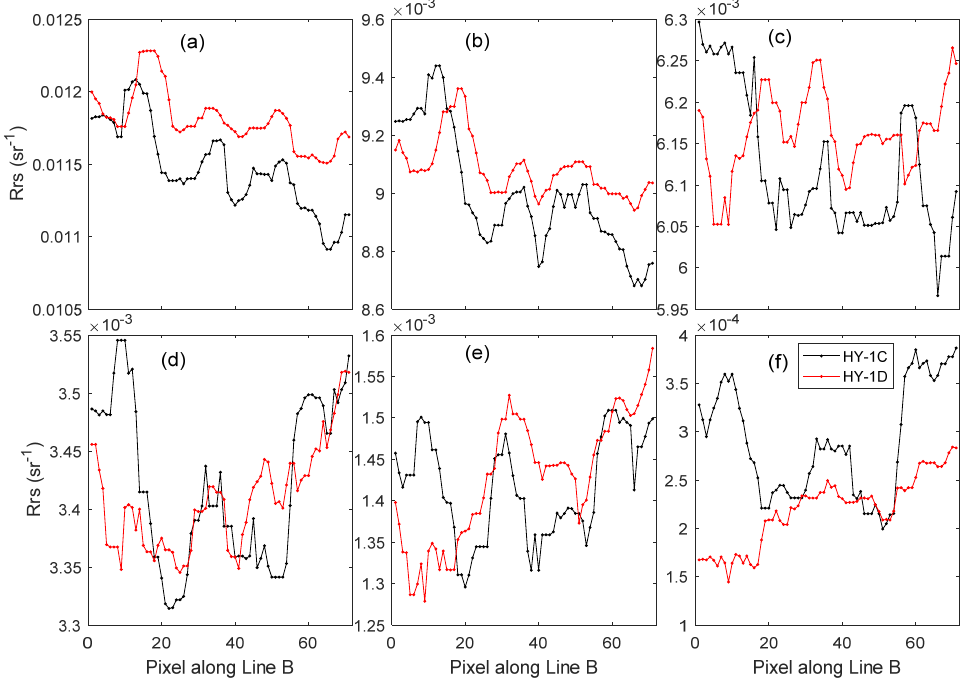
Figure 13. The comparison of R rs values between HY-1C and HY-1D along Line B (location shown in Figure 1) from Band 1 ( a – f ) to Band 6.